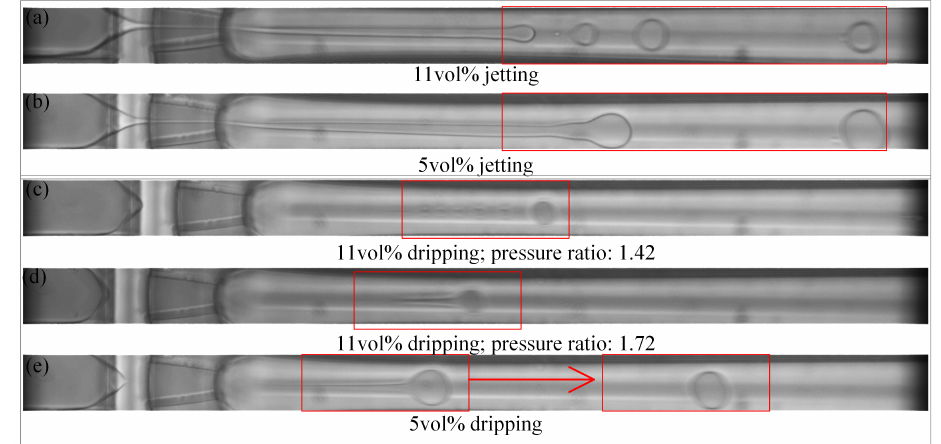
Figure 7. The droplet formation under jetting and dripping mode for different bulk concentration of surfactant: 11 vol % and 5 vol